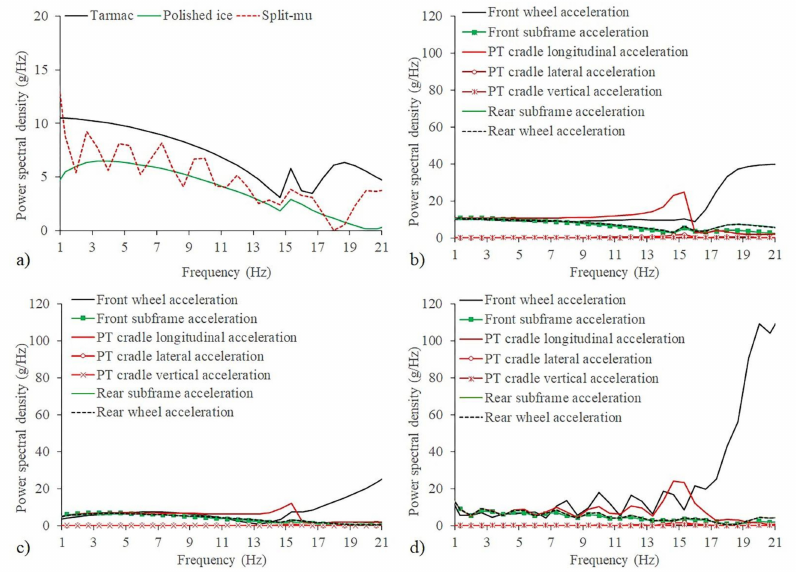
Figure 10. Tip-in event low-frequency resonances of component acceleration: ( a ) vehicle body longitudinal on different road mu; ( b ) dominant component on the tarmac; ( c ) dominant components on polished ice; ( d ) dominant components on split-mu.